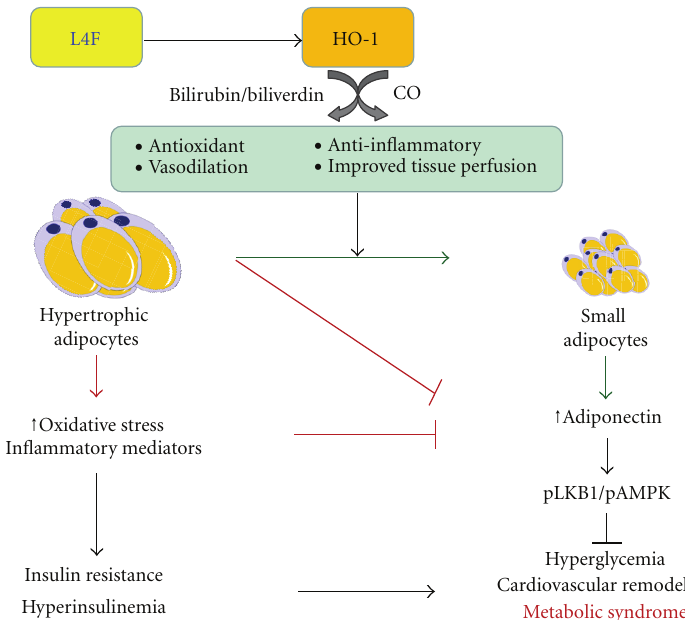
Figure 5: Schematic, the upregulation of HO-1 and adiponectin levels by L-4F coincides with increased pAMPK and LKBI levels providing a signaling mechanism by which L-4F rescues the metabolic phenotype and improves vascular